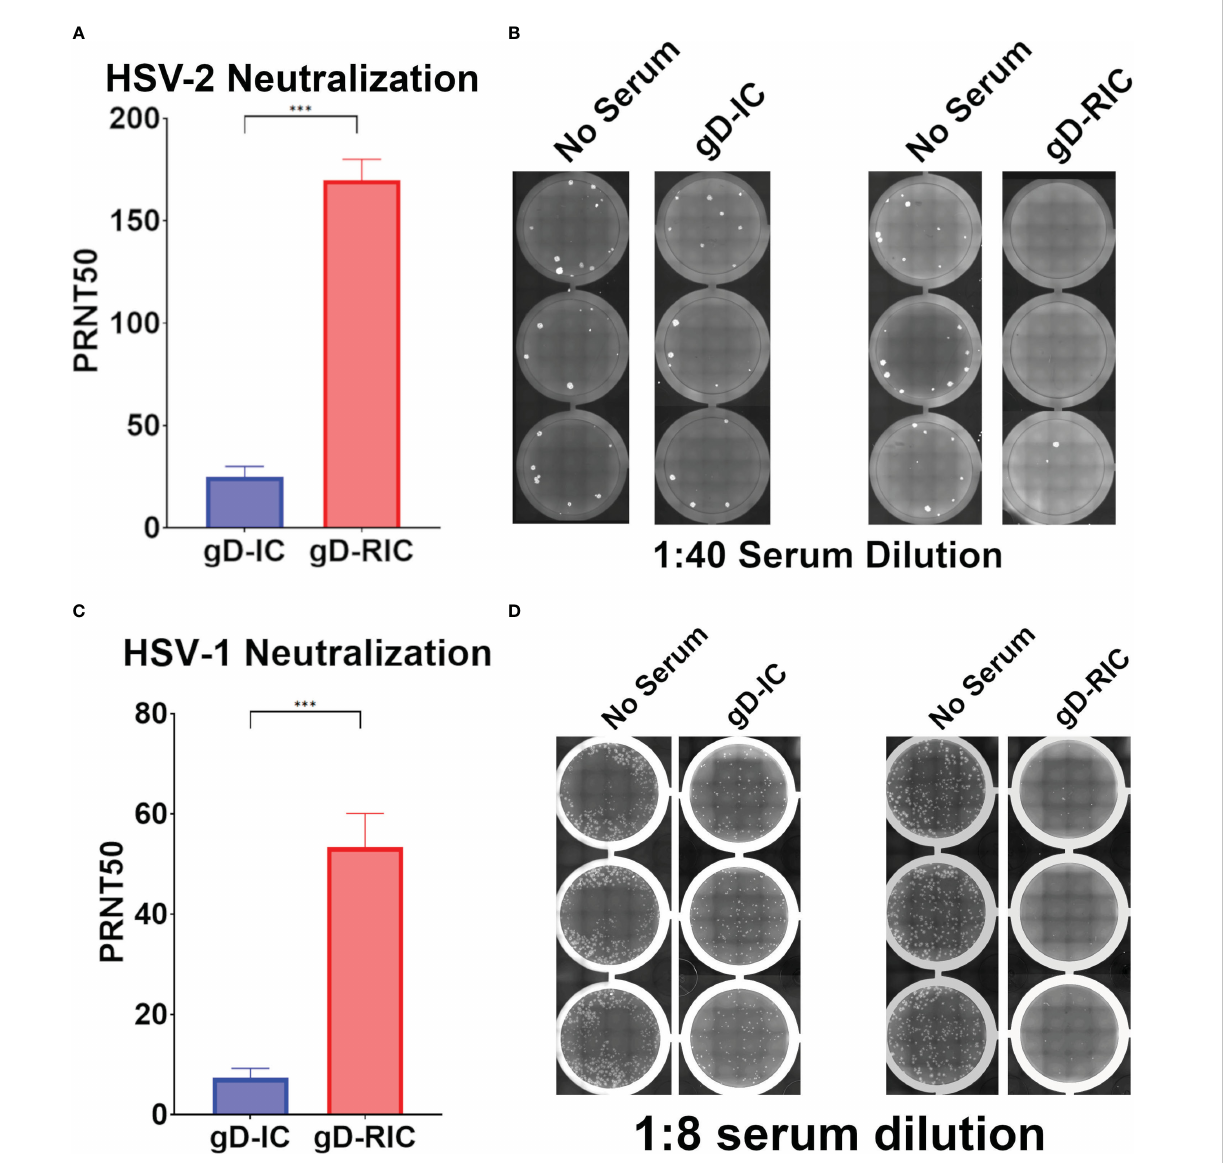
FIGURE 6 Neutralization of HSV-2. Plaque reduction neutralization 50 (PRNT50) assays of (A, B) HSV-2 or (C, D) HSV-1 were performed using serially diluted mouse serum samples from dose 3. Data represent the mean and standard error from four samples for HSV-2, or six samples for HSV-1. Three stars (***) indicates p < 0.001 by student ’ s t -test. Representative images showing virus plaques from 3 replicate serum-containing wells and 3 replicate control wells are shown for both HSV-2 and